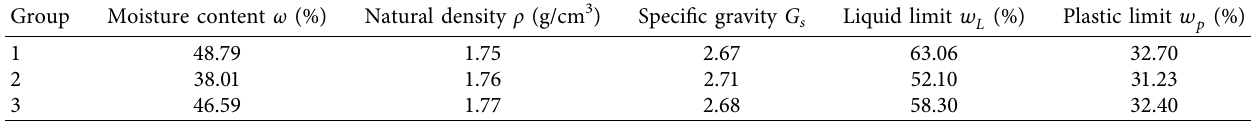
Table 1: Test results of physical properties of Zhanjiang Formation clay.